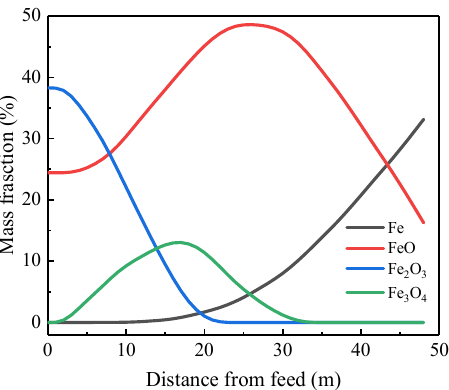
Figure 10. Average mass fraction of solid composition in the bed region along the axial section.